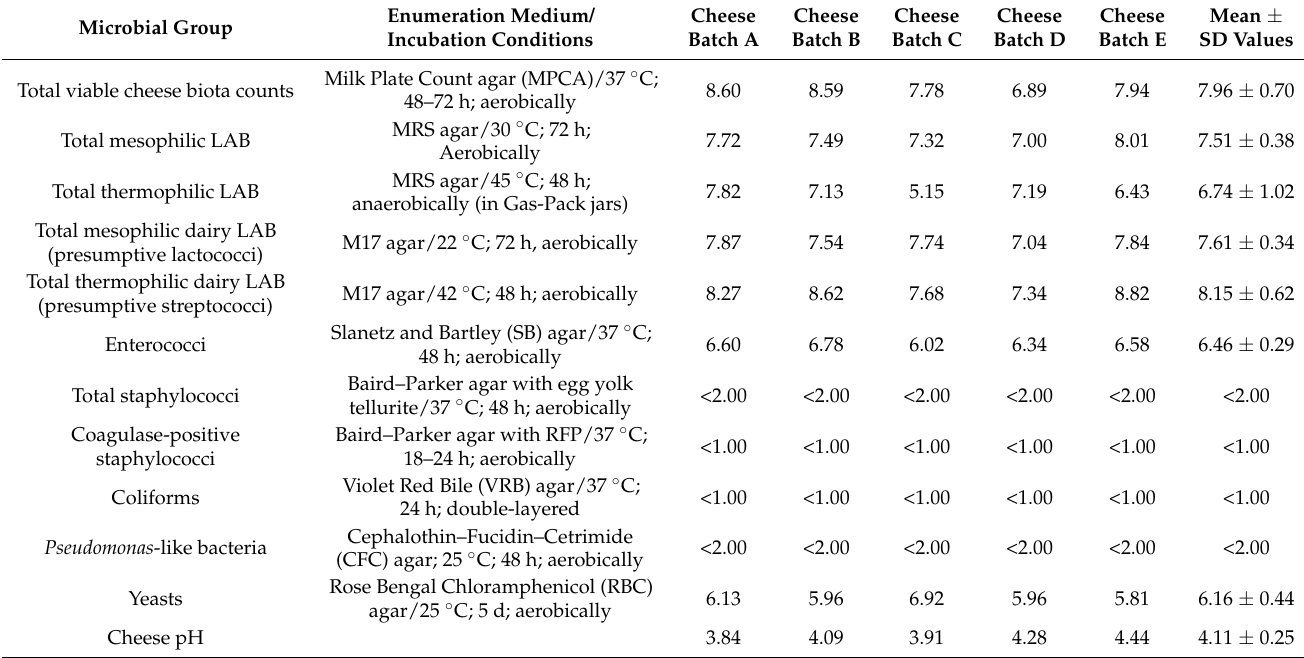
Table 1. Microbial populations (log CFU/g) and pH values of five retail individual batches of RTE Galotyri-like acid-curd cheese. Microbial